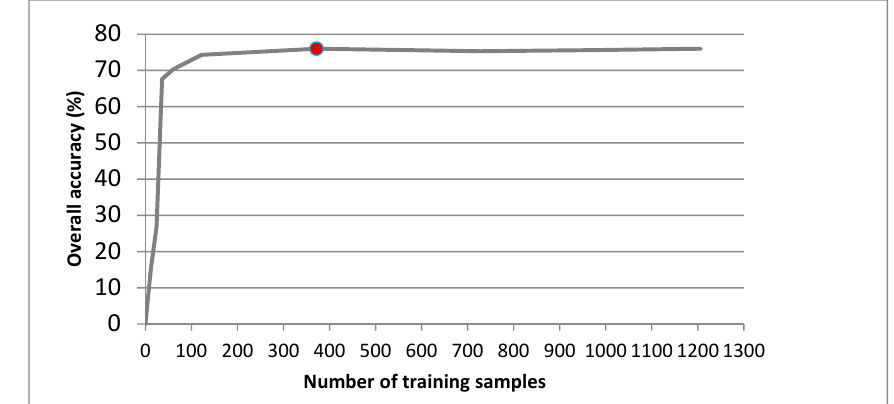
Figure 5. The performance of the different sample sizes of the maximum likelihood classification with the Belgian grid as reference data. The graph shows that when the training size was large enough (more than 100 samples), the classification accuracy only slightly increased. At 372 samples (30% of the total training data), the overall accuracy (OA) reached a maximum. After that, it slightly decreased and finally increased slowly to reach the same OA.